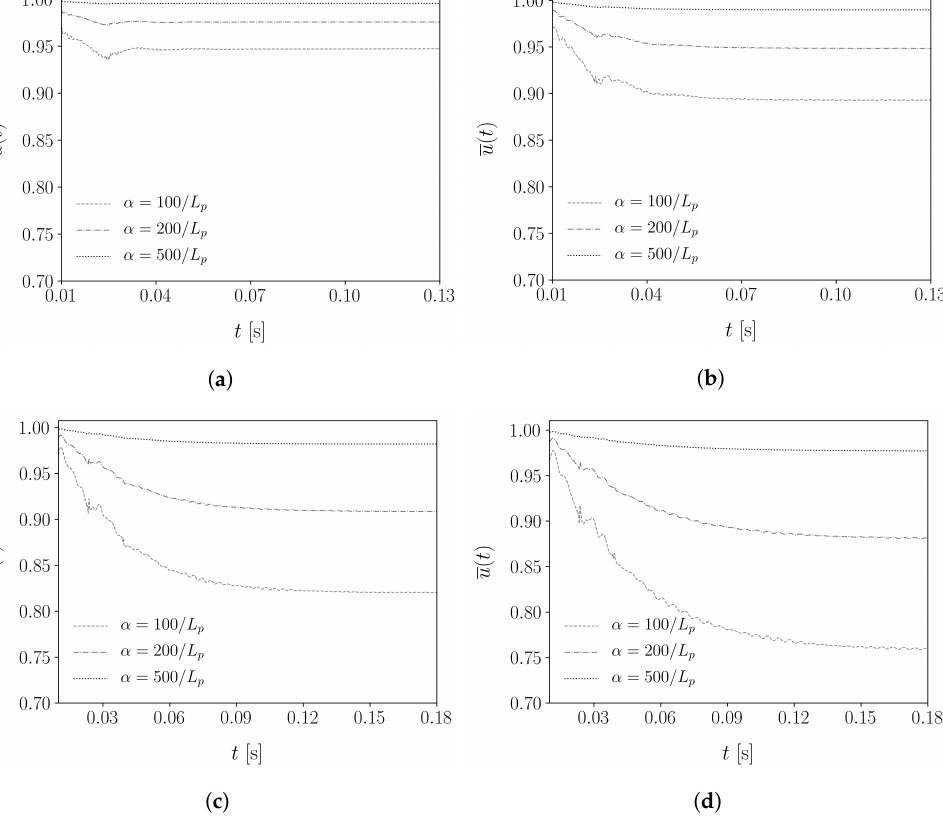
Figure 11. Displacement ratio of non-local to local reaction models, u ( t ) = u ( L p , t ) / u ( L p , t ) and ( a ) R p = 1.1 m, ( b ) R p = 2.0 m, ( c ) R p = 3.2 m and ( d ) R p = 4.1